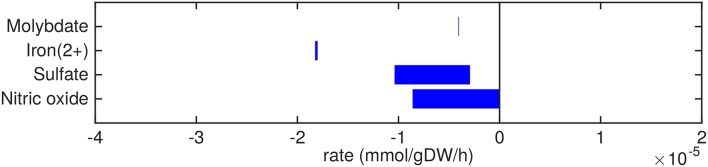
Predicted uptake and secretion rates of cofactors and small molecules by Mtb in the host. Predicted ranges of uptake and secretion rates (mmol gDW−1 h−1) of cofactors and small molecules by Mtb inside the host are indicated by blue bars. Negative values denote uptake and positive values denote secretion.